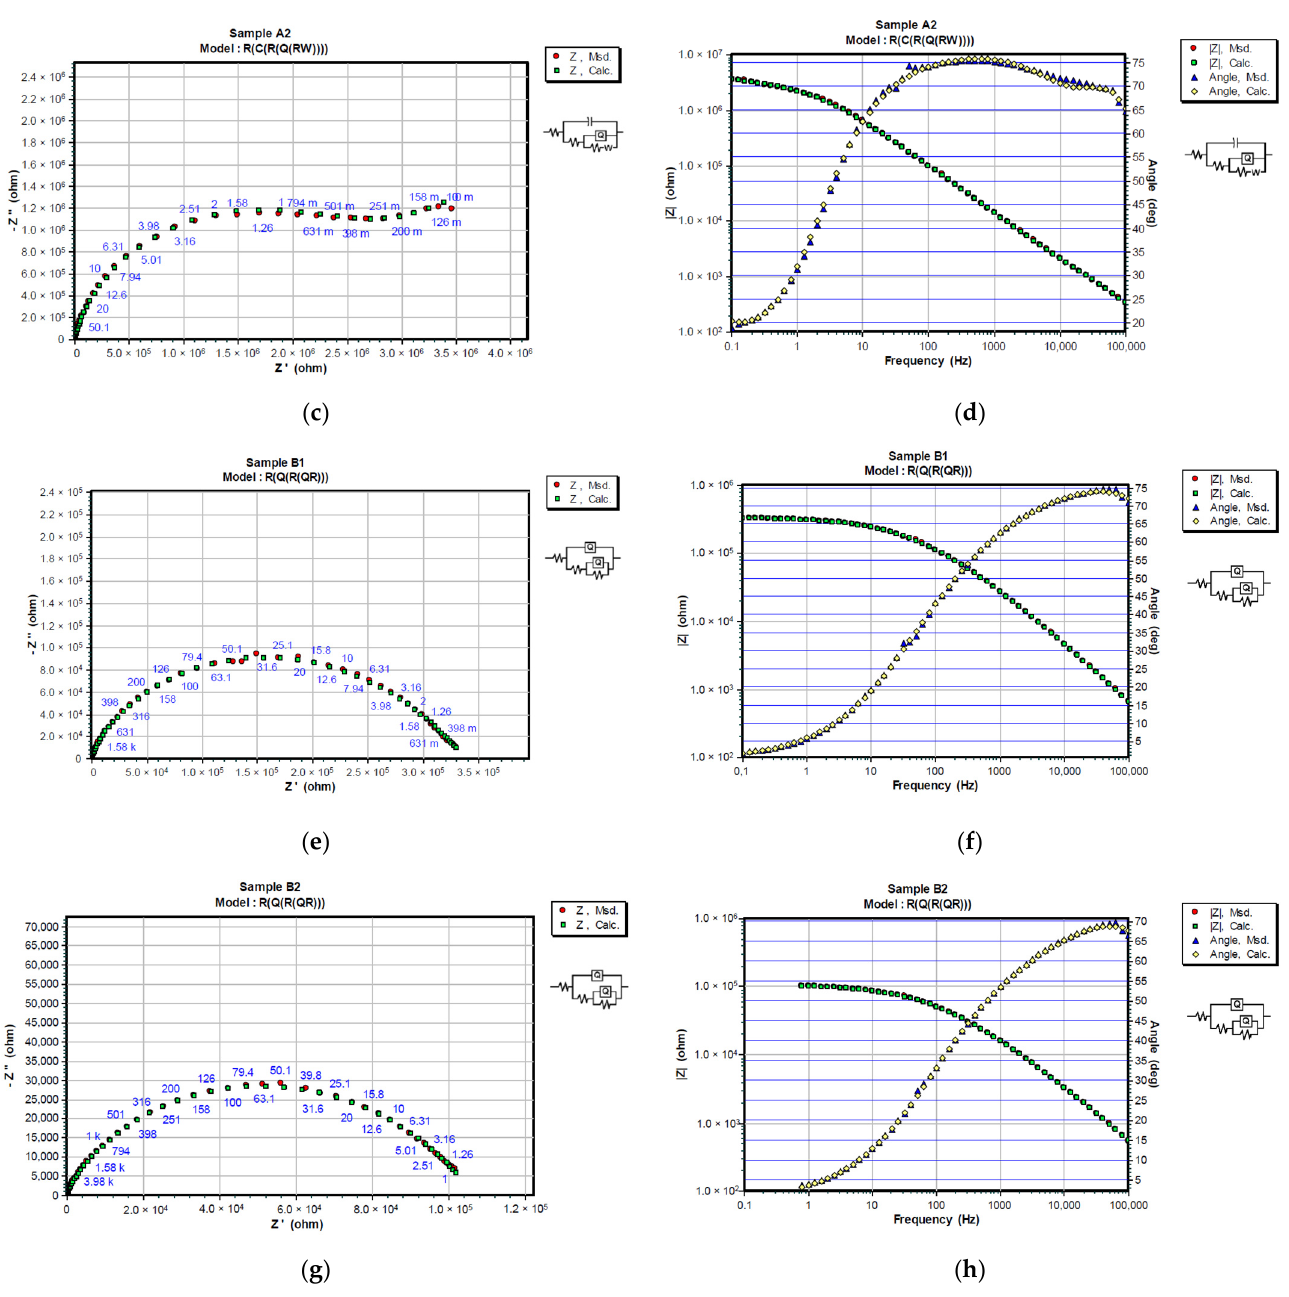
Figure 8. Representation of CNLS simulated and experimental data for each sample after 720 h in 3% NaCl solution with Nyquist and Bode plots. Nyquist diagrams are represented in ( a ) A1, ( c ) A2, ( e ) B1 and ( g ) B2, while Bode and Phase-angle plots are shown in ( b ) A1, ( d ) A2, ( f ) B1 and ( h ) B2. Table 8. Fitted values of equivalent circuit elements (R s , C c /Q c , R c , Q dl , R ct , W) and the corresponding chi-square value ( χ 2 ) after 720 h xin 3%